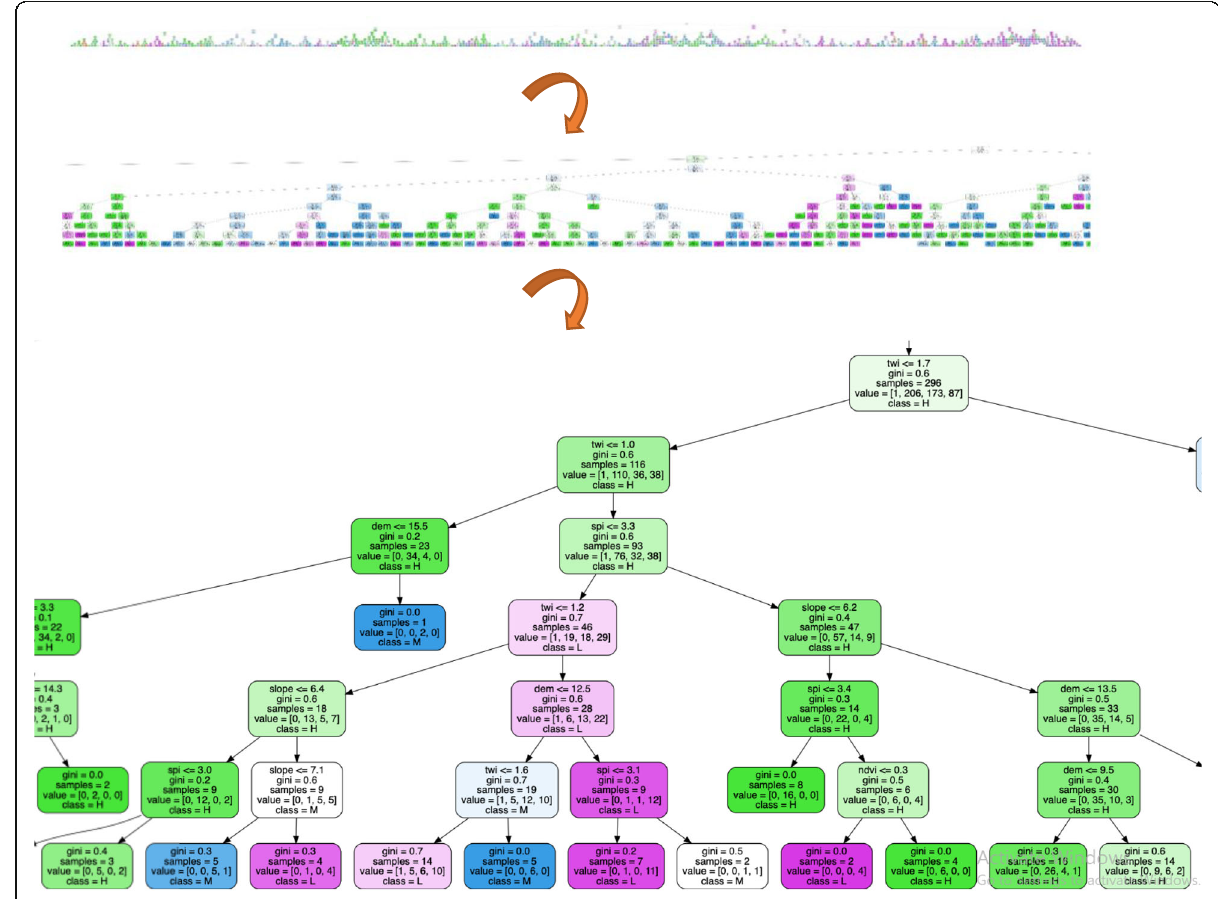
Fig. 10 Visualization of the Decision tree (leaf